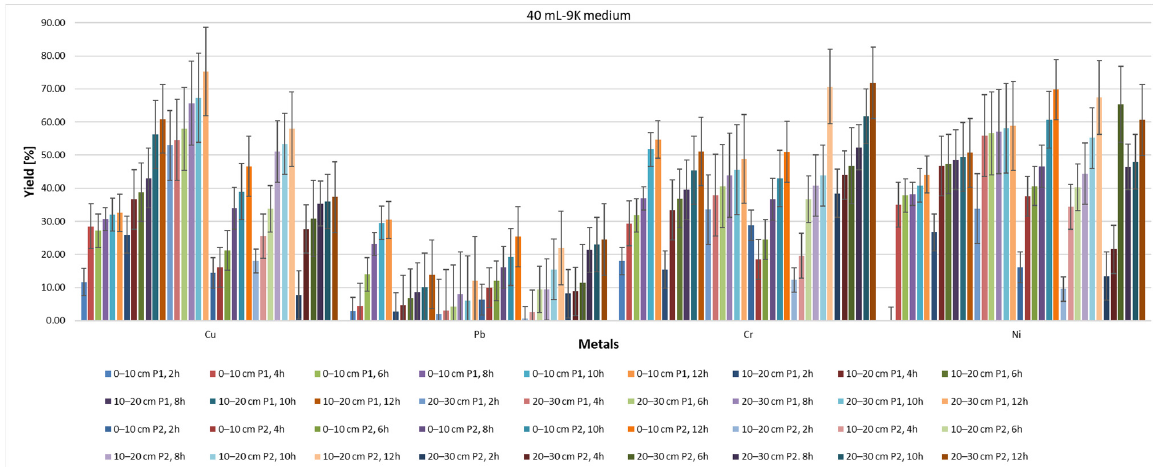
Figure 11. Yield of extraction process with 20 mL of 9K medium.